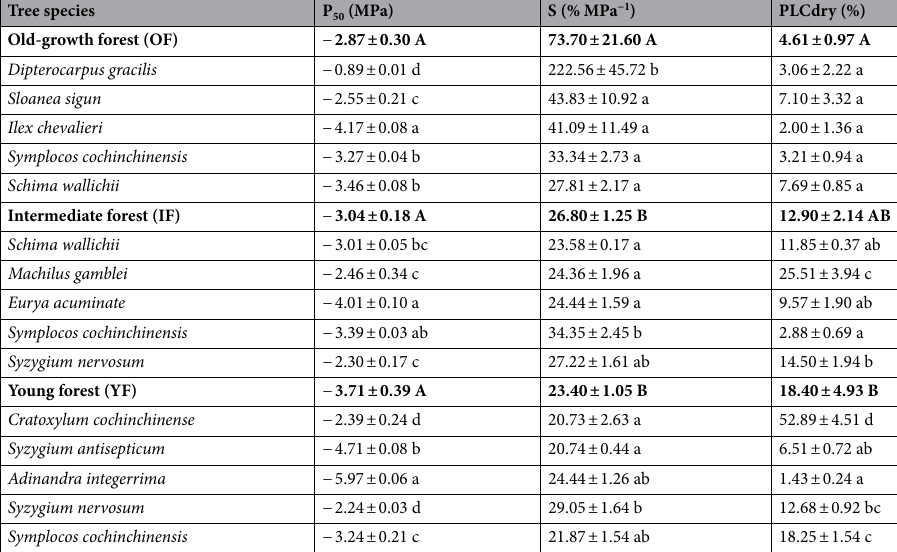
Table 2. Vulnerability to xylem embolism, represented by xylem pressure at 50% loss of hydraulic conductivity (P 50 ), slope of the vulnerability curve (S), and percentage loss of hydraulic conductivity corresponding to midday leaf water potential during the dry season (PLC dry ) of selected dominant tree species from different successions in Khao Yai National Park, Thailand. For a given species, values are means ± one standard error of 3 sampled branches that we used to generate the vulnerability curve separately. For each successional stage, values presented are averaged from the selected dominant tree species with one standard error (n = 15). Different upper- and lower-case letters represent significant differences among the forest successions and within each forest succession, respectively (One-way ANOVA with Tukey’s post-hoc test, significance level of